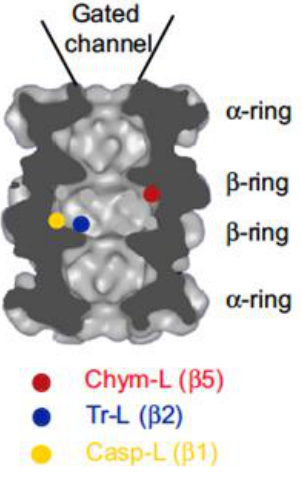
Figure 1. Cross-section of the 20S proteasome showing the location of the active sites. Cut surfaces are dark grey. Active sites are indicated with a colored dot. Chym-L, chymotrypsin-like; Tr-L, trypsin-like; Casp-L, caspase-like. Reprinted from [11], with permission from Elsevier.